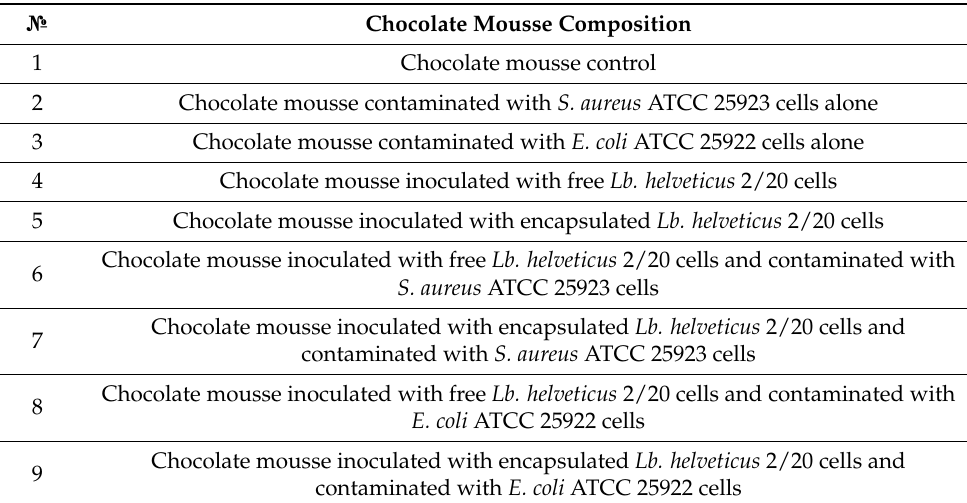
Table 1. Samples of chocolate mousse with lactobacilli and pathogenic bacteria.